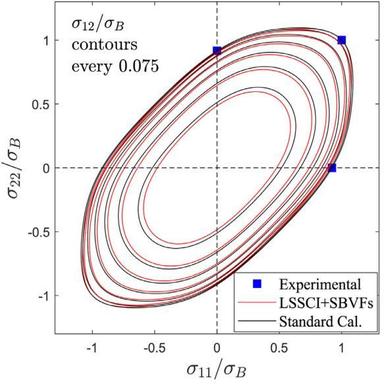
Yield surfaces by employing the standard procedure and the proposed decoupled identification strategy, normalized by their respective balanced biaxial stresses.